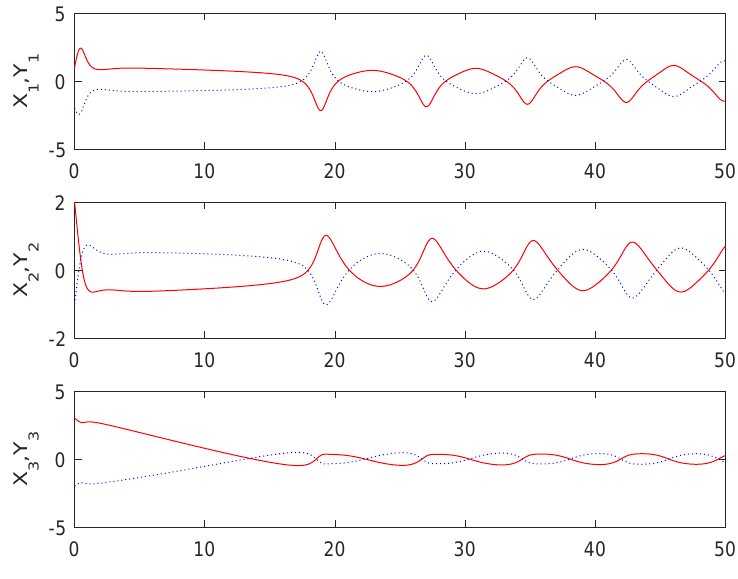
Figure 2. The states of the master subsystem and the slave